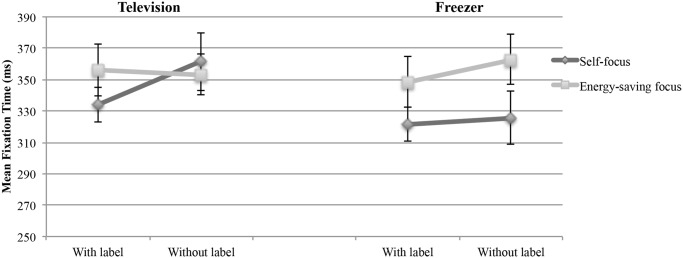
Mean fixation duration on energy information as a function of label (with vs. without label) and focus (self vs. energy saving). The error bars represent the standard error.